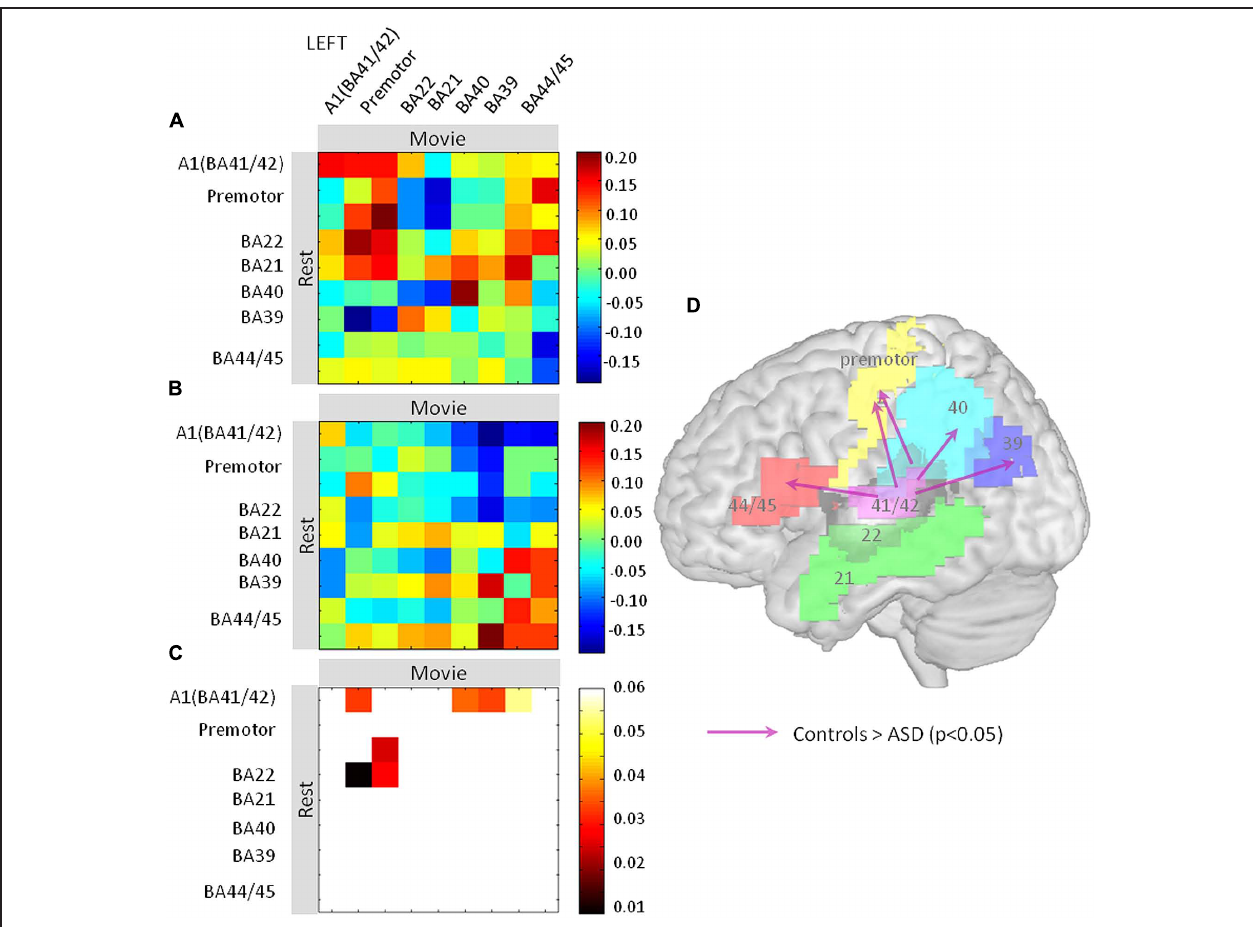
FIGURE 4 | Oscillation-based functional disconnection of auditory cortex in autism. (A,B) We quantified how the oscillatory spectrum in auditory cortex at rest propagated to the other regions of the left lateralized language network during the movie, in controls (A) and in ASD subjects (B) . We used Pearson’s correlation matrices of the EEG-BOLD correlations over the whole spectrum (1–70 Hz) across nine regions of the language system. The results are